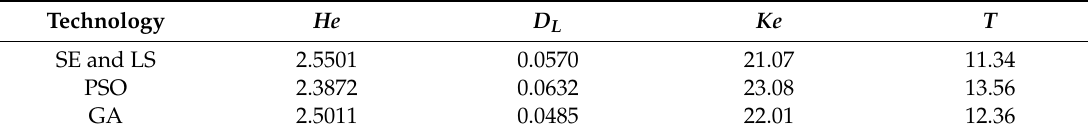
Table 3. Parameters of the simplified SFR model.